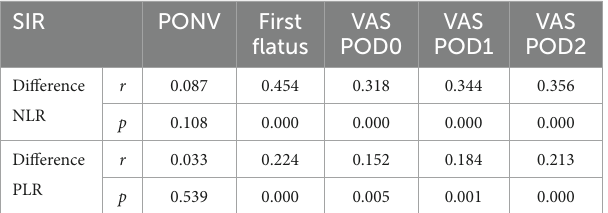
TABLE 4 Correlation analysis between PONV, first flatus time postoperatively, VAS score in postoperative days POD0, POD1, and POD2 of patients following gynecologic surgery and the perioperative difference between neutrophil-to-lymphocyte ratio (NLR) and platelet- to-lymphocyte ratio (PLR).